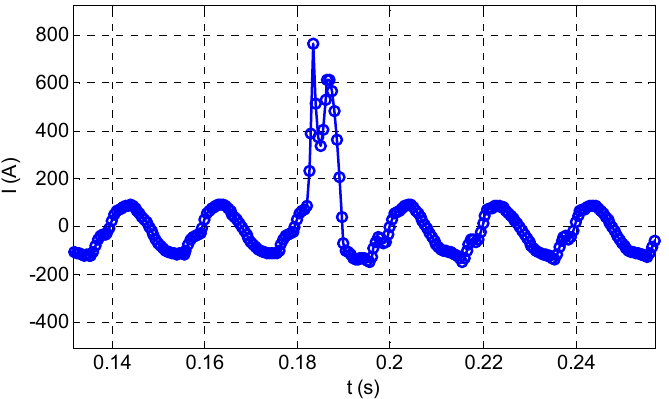
Figure 3. Real case of a sub-cycle self-extinct fault in a 10 kV underground distribution system. This fault lasts for about half a cycle until it is cleared when the fault current passes by zero.